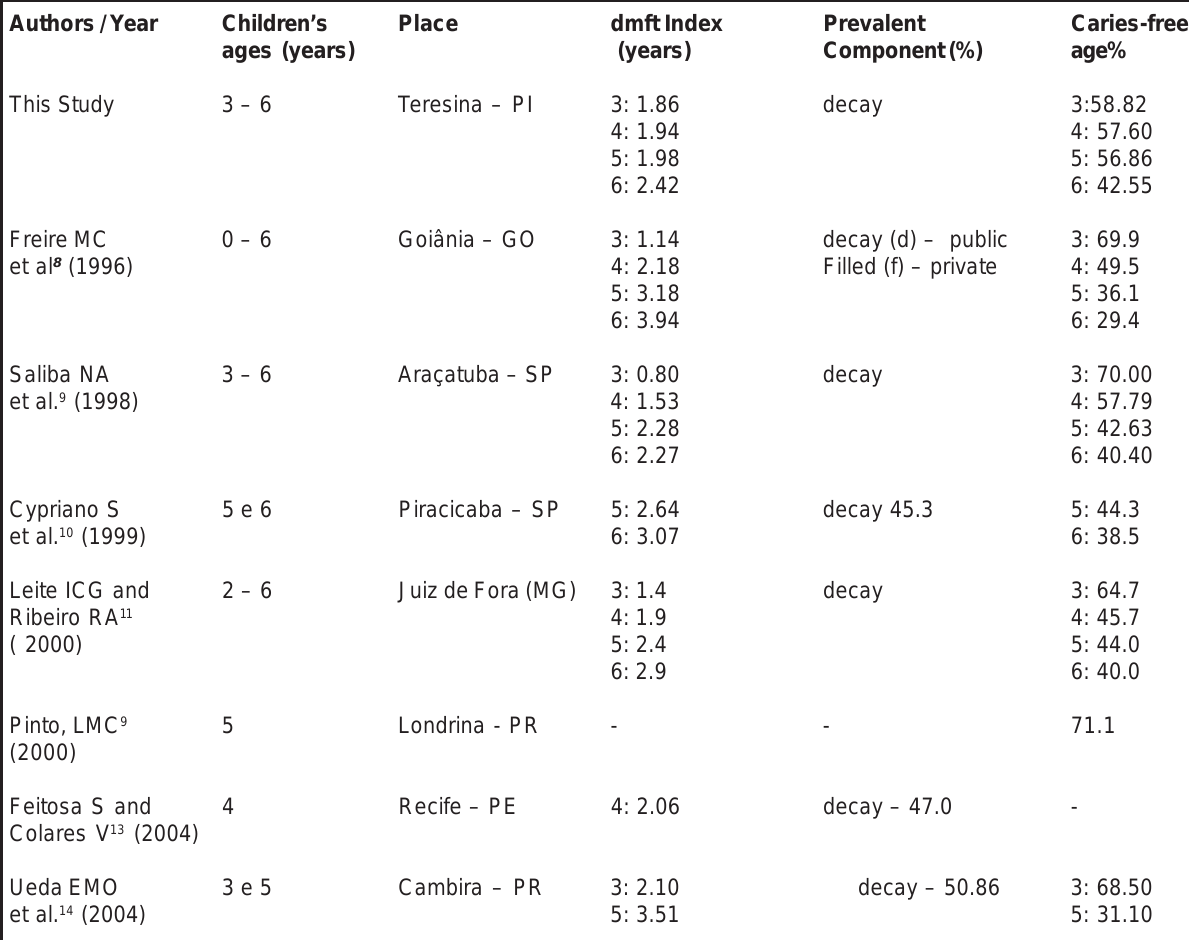
FIGURE 4- Prevalence of dental caries in primary teeth in various Brazilian